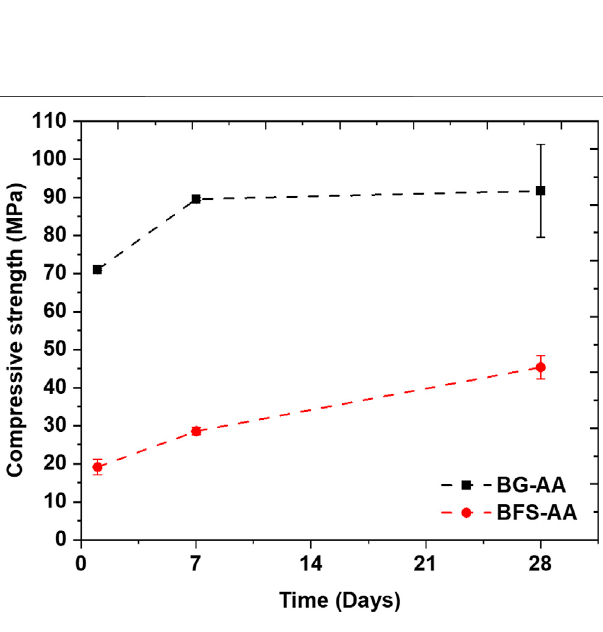
Frontiers in Chemistry |